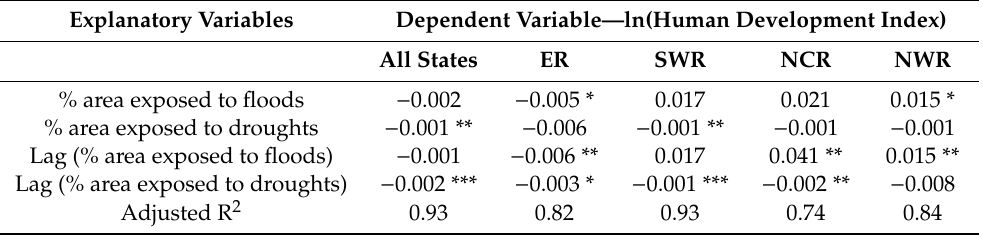
Table 8. Regressions of flood and droughts a ff ected areas with human